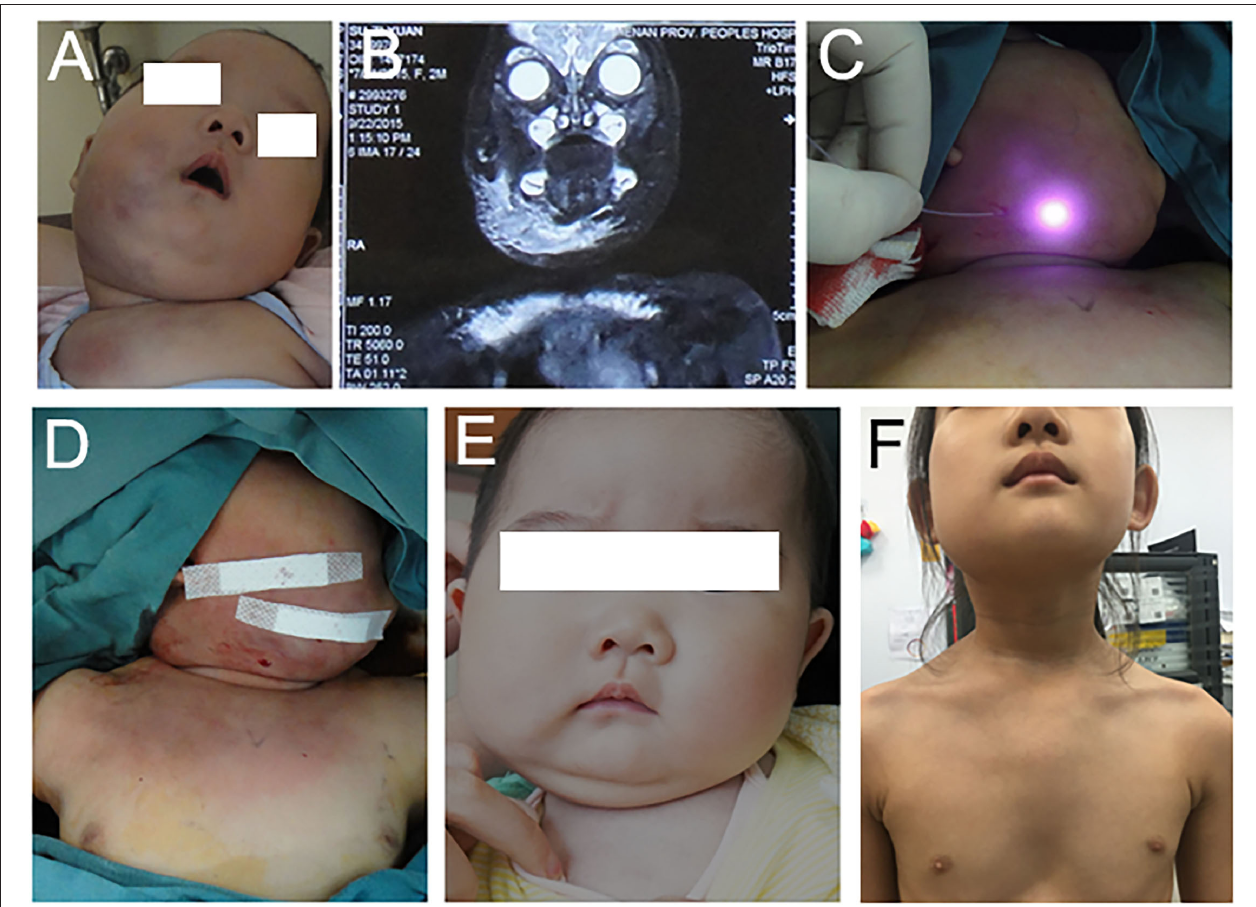
FIGURE 1 | The patient was diagnosed with KHE with KMP. (A) The patient showed a lesion on her right face, chin neck, and chest wall at 2 months. (B) Magnetic resonance imaging with contrast enhancement performed at 2 months. (C,D) The patient received the first course of IPL and sclerotherapy at 4 months. (E) The tumor recessed at 10 months. (F) The tumor recessed at 6